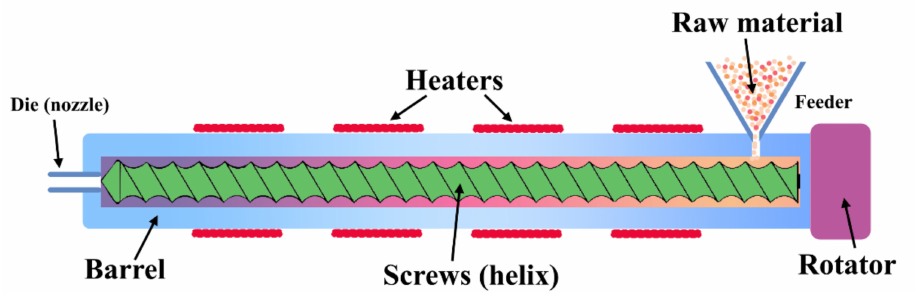
Figure 2. A simple schematic of extrusion processing, demonstrating the transformation of the raw ingredient (such as proteins and other reinforcement materials) to molded